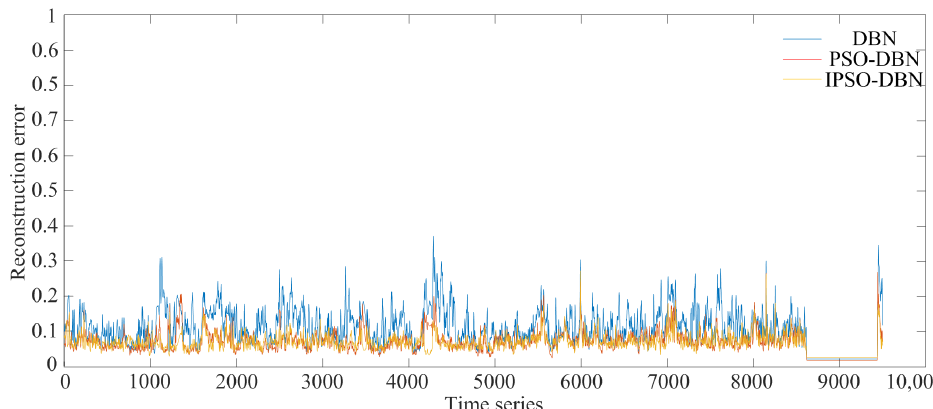
Figure 6. Reconstruction error results of different models.